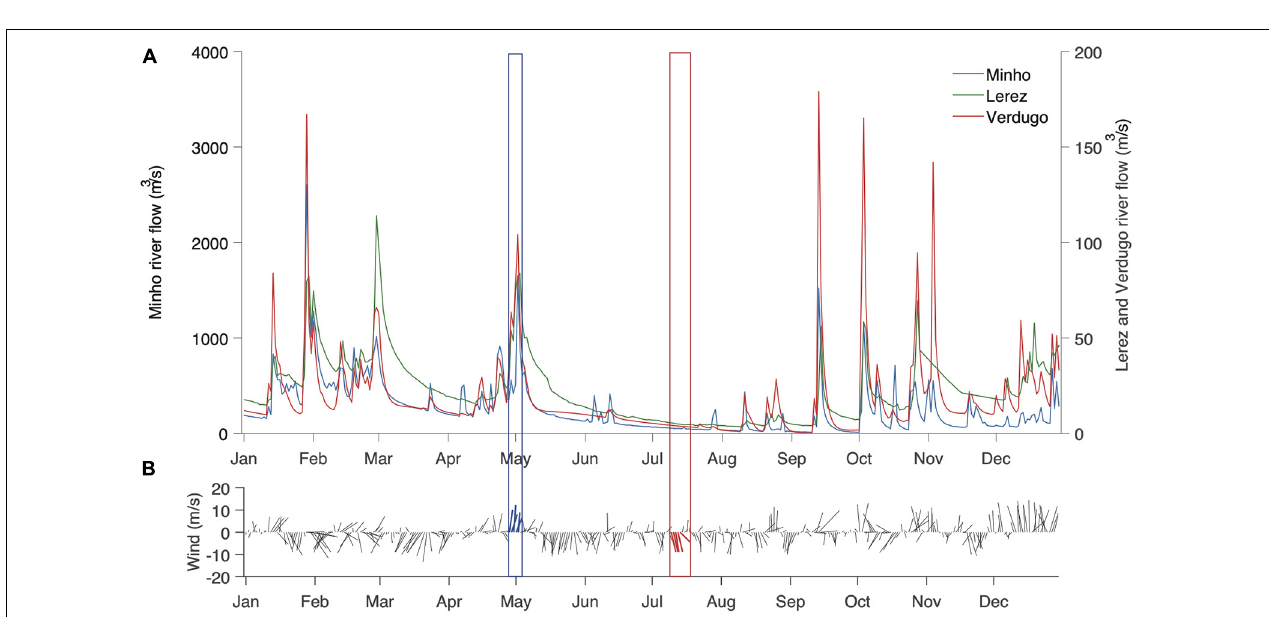
FIGURE 2 | Bathymetry of the Ría de Pontevedra and surrounded shelf, with isobaths at 10 m intervals, cross-sections (red lines), INTECMAR CTD stations (red dots), and along-Ría section (black thin line) used below. Wind point data (white cross) is located offshore. Origin of vertical sections displayed in Figure 9 is designated by black small squares superimposed on red lines. Sea level gauge location is represented by a black square.